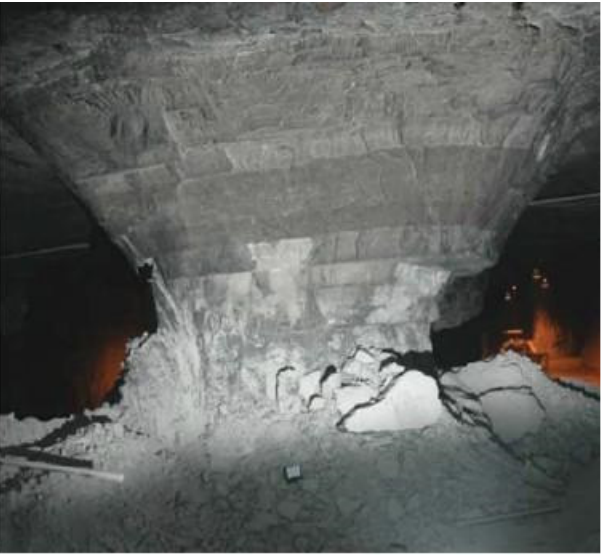
Figure 1. Joints with different inclinations in pillars [19].